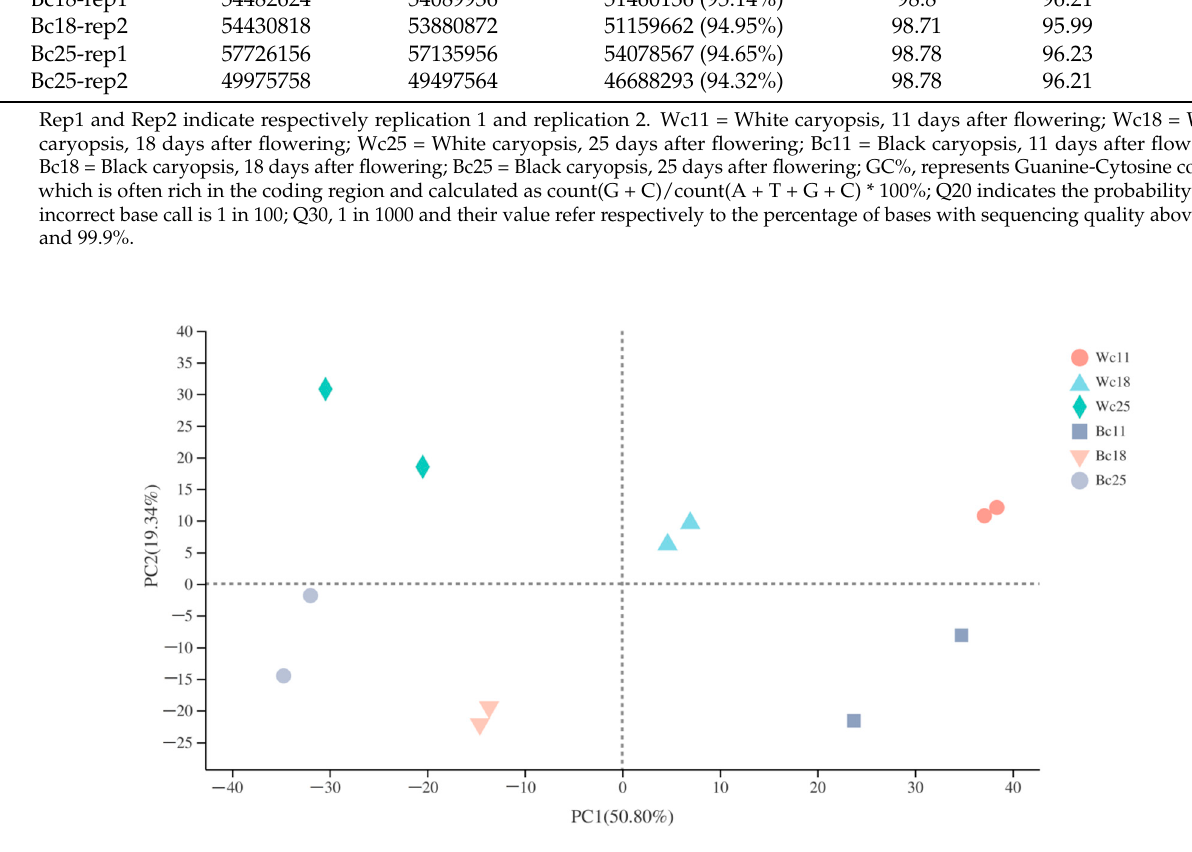
Figure 4. Principal component analysis of replicates samples at different developmental stages. Wc11 = White caryopsis, 11 days after flowering; Wc18 = White caryopsis, 18 days after flowering; Wc25 = White caryopsis, 25 days after flowering; Bc11 = Black caryopsis, 11 days after flowering; Bc18 = Black caryopsis, 18 days after flowering; Bc25 = Black caryopsis, 25 days after flowering. The distance of each sample point represents the distance of the sample. The closer the distance, the higher the similarity between the samples. The horizontal axis represents the contribution of principal component 1 (PC1) to the distinguished sample in the two-dimensional graph, and the vertical axis represents the contribution of principal component 2 (PC2) to the distinguished sample in the two-dimensional graphs.